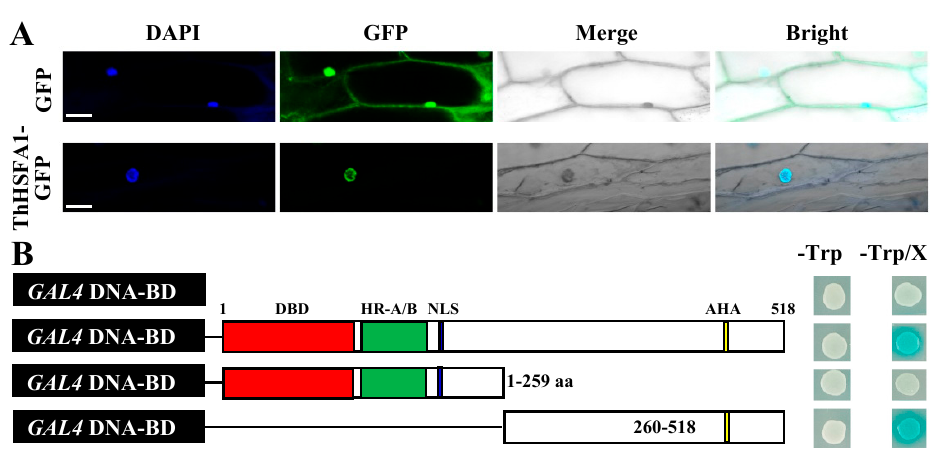
Figure 3. Subcellular localization and transcriptional activation assay of ThHSFA1. ( A ) Subcellular localization of ThHSFA1 protein. The 35S::GFP (control) and 35S::ThHSFA1-GFP were transformed into onion epidermal cells and visualized by DAPI staining. Scale bars = 10 µ m. ( B ) Transcriptional activation activity of ThHSFA1 protein. The full-length and fragment cDNA of ThHSFA1 were fused to the GAL4 DNA-binding domain in the yeast vector pGBKT7 and expressed in Y2HGold yeast cells. The transformed yeast cells were plated on SD/ − Trp and SD/ − Trp/X- α -Gal media and then subjected to a β -gal assay.